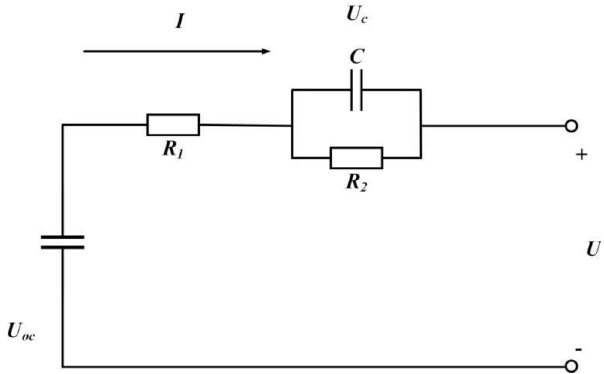
Figure 1. The circuit of the first-order resistor–capacitor (RC)